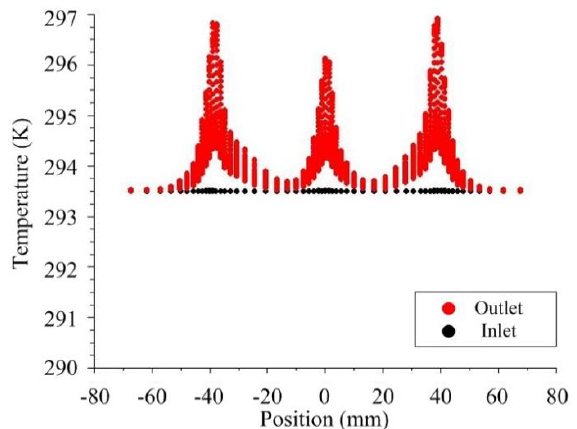
Figure 12. Comparison of temperature changes at different positions on the inlet and outlet of the water tank.